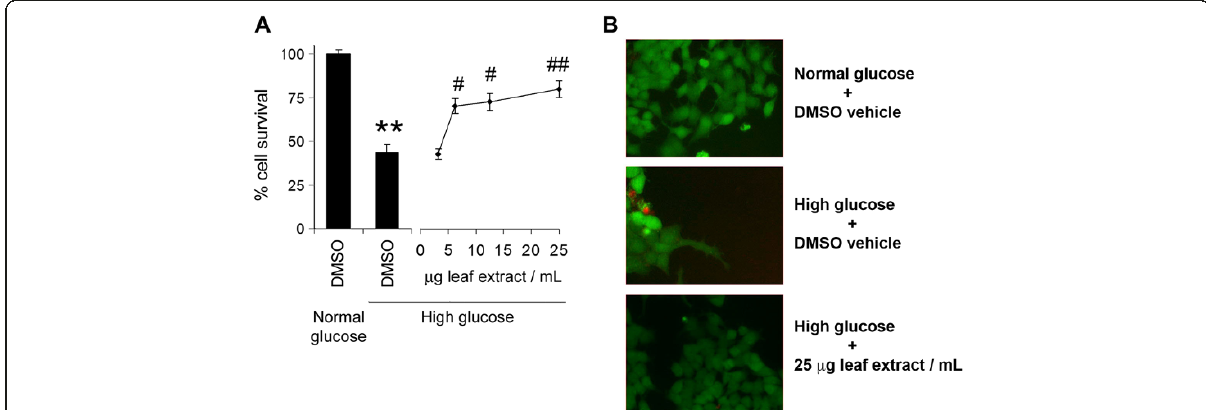
Figure 2 Leaf extract of Sarracenia purpurea prevents high glucose-mediated cytotoxicity. ( A ) Exposure to glucose toxicity elicited a significant loss in cell survival compared to normal glucose conditions as assessed by Live/Dead assay [left panel, ** denotes a significant difference ( p < 0.01) relative to normal glucose control, Student ’ s t -test, n = 8]. Multiple concentrations of leaf extract were administered to high glucose-treated cells to confirm cytoprotection [right panel, # and ## denote significant differences ( p < 0.05 and ## p < 0.01, respectively) relative to high glucose control, ANOVA, post-hoc Dunnett ’ s t -test, n = 8]. ( B ) Treatment with 25 μ g/mL of leaf extract reversed high glucose-induced loss of PC12 cells, which were identified by intracellular cleavage of calcein-AM to its fluorescent product (green cells) without loss of membrane integrity (red cells). Data are reported as the mean ±